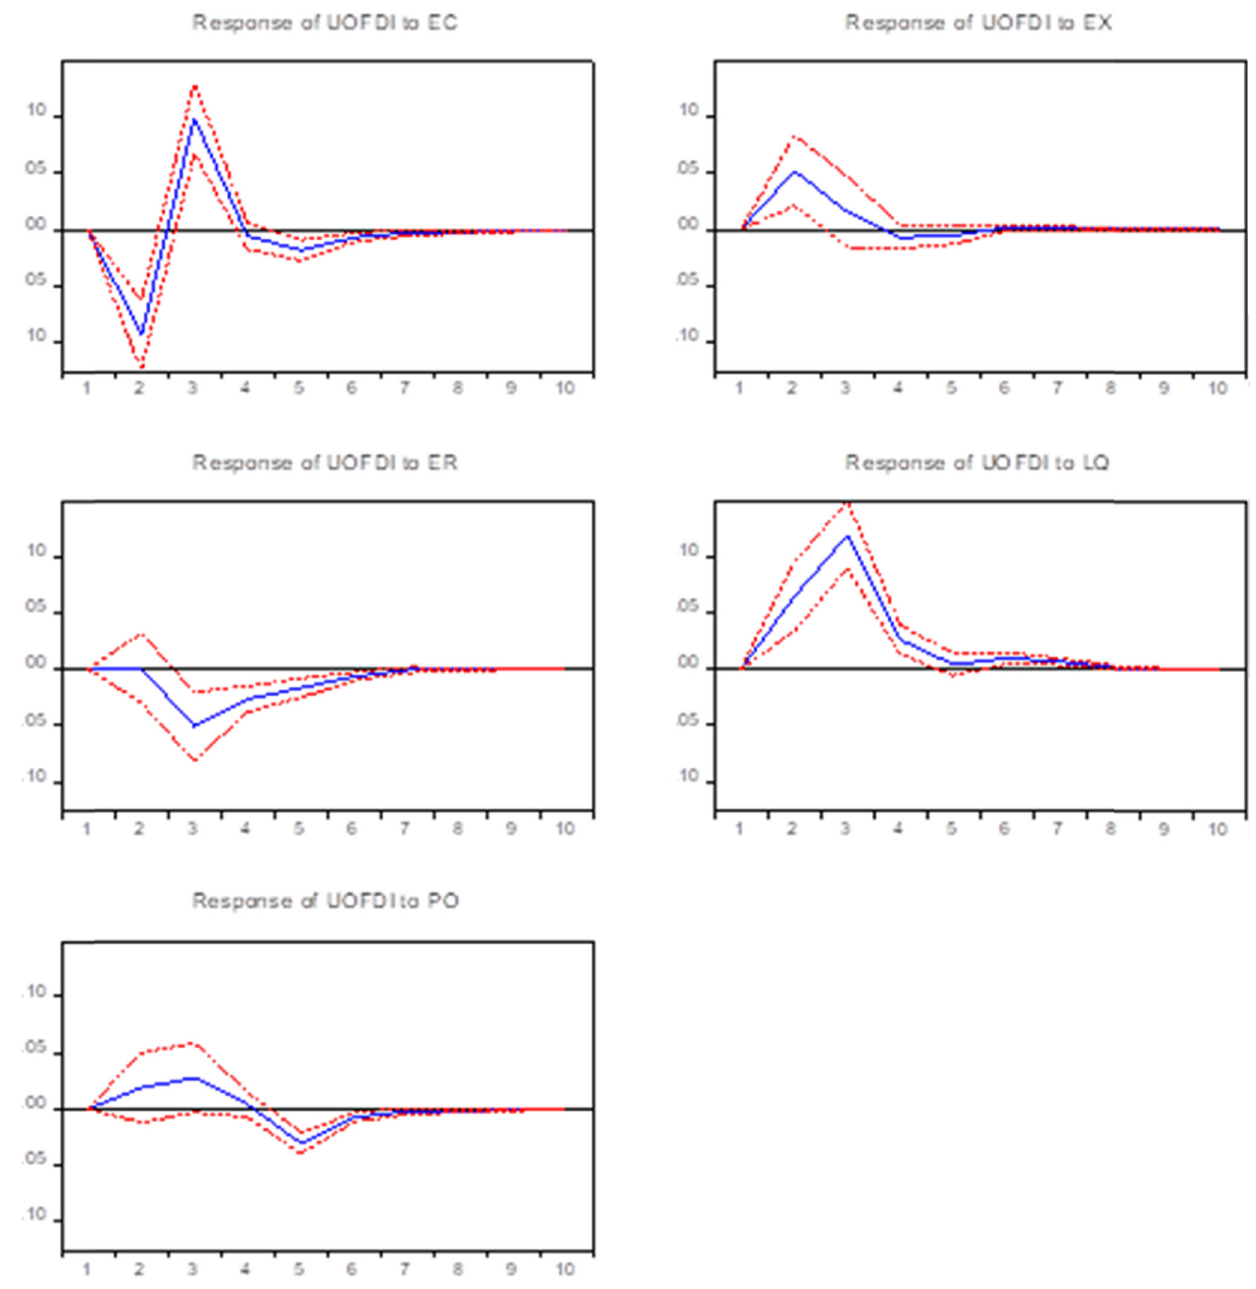
Fig. 3 Impulse response functions results for USA.